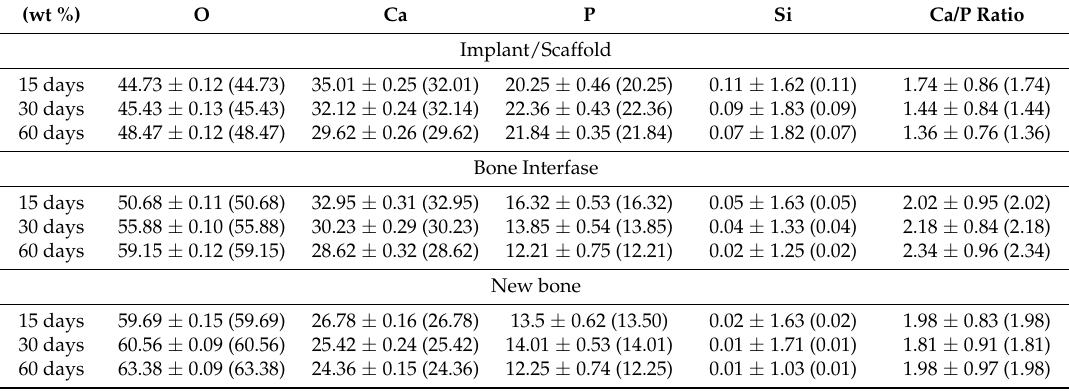
Table 2. The EDS elemental analysis of the reaction zone at 15, 30 and 60 implantation days. Mean ± SD (median).